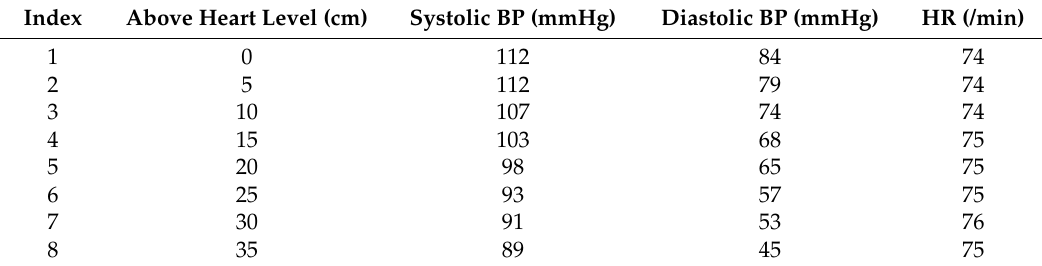
Table 1. Systolic BP, diastolic BP and HR at different height